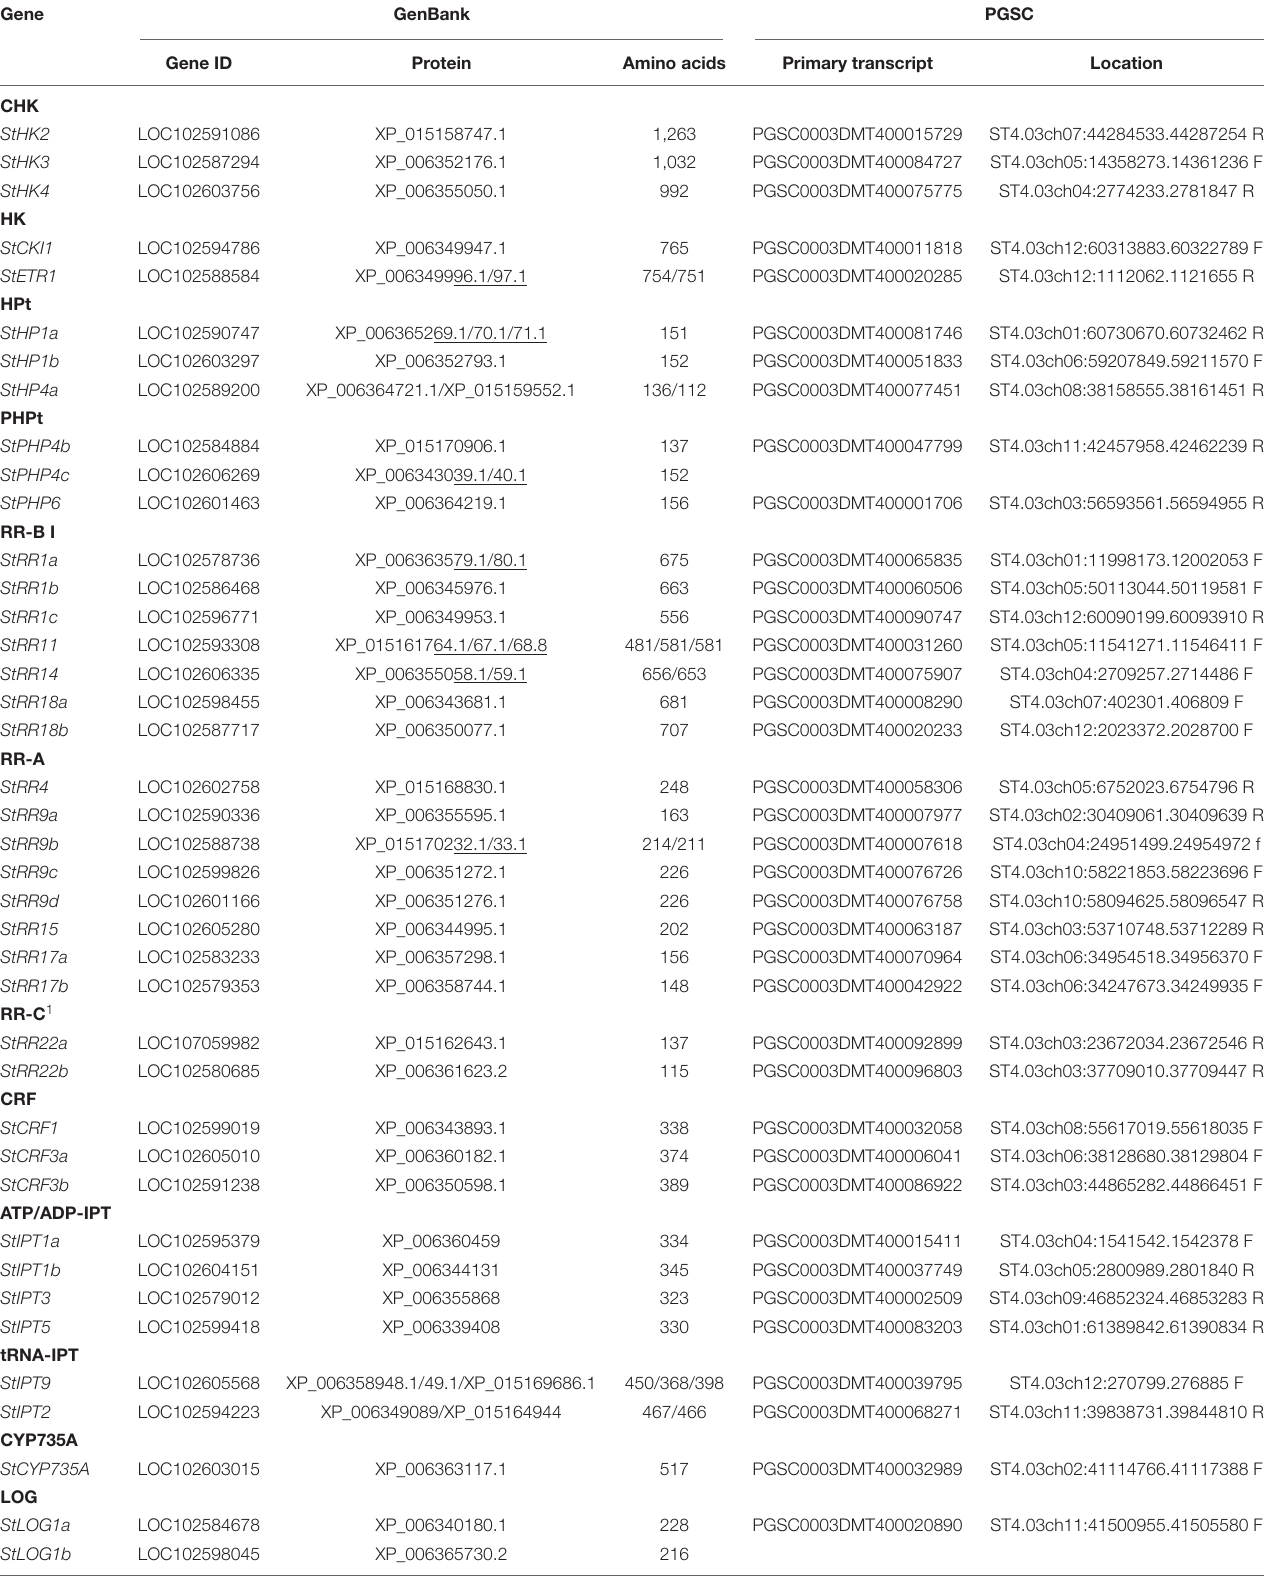
TABLE 1 | Proven or high-probable components of the CK regulatory system in DM